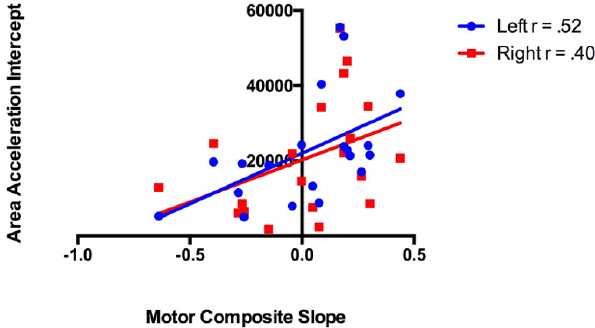
Figure 14. Scatter plot of normalized area of acceleration intercepts (for right and left arms) and Bayley composite motor slopes of each infant.